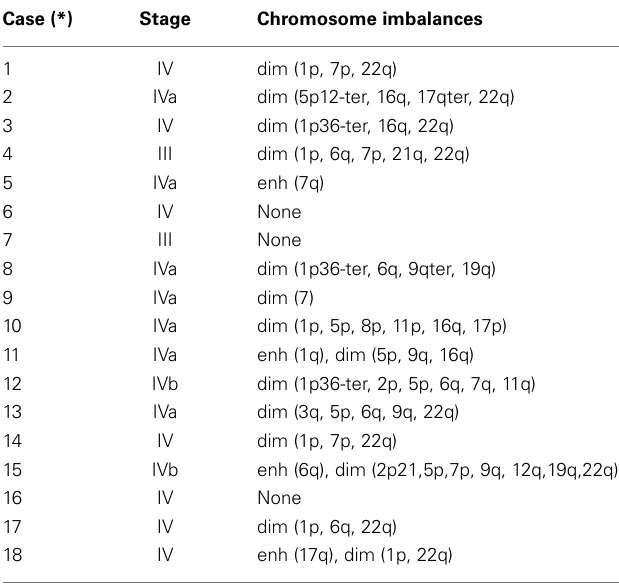
Table 2 | Genetic aberrations in endometriotic tissues detected by comparative genomic hybridization